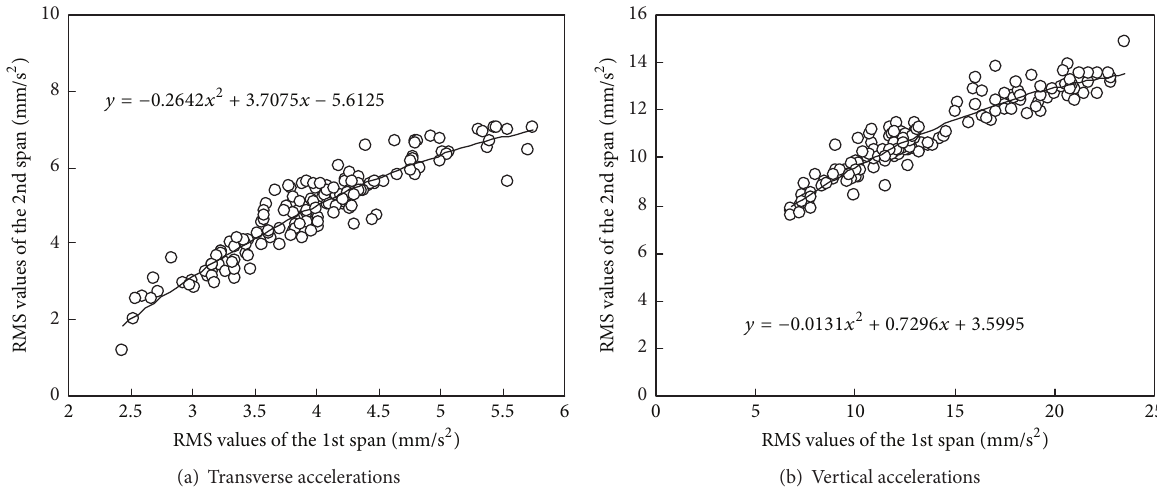
Figure 8: Cross-correlations between RMS values of accelerations measured in the middle of two main spans.